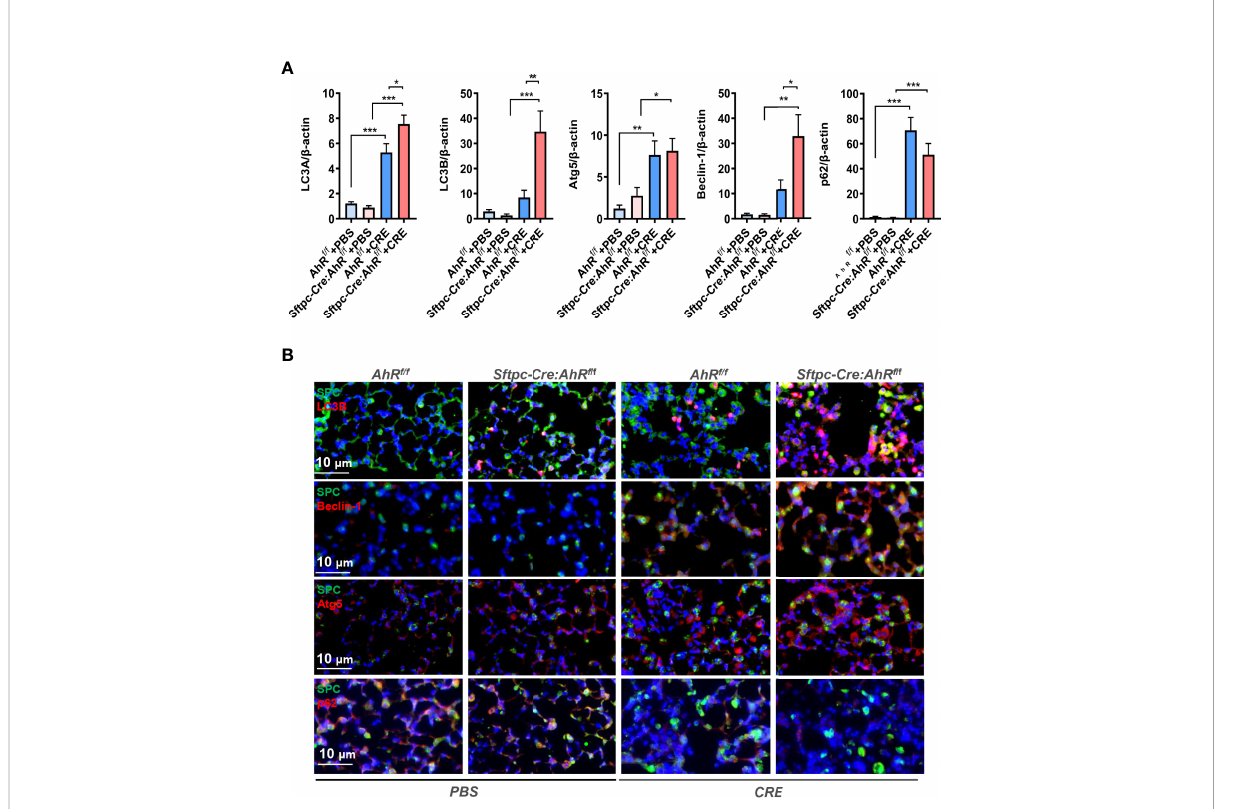
FIGURE 3 Type II alveolar epithelial cell AhR protects against allergen-induced autophagy in a mouse model of asthma. (A) RT-PCR analyses of autophagy-related genes in the lung tissues of asthma mouse model. n = 8 – 12. (B) Representative images of co-immuno fl uorescence staining of autophagy-related genes with AT2 marker SPC. n = 6. Data in (A) represent means ± SEM. * p < 0.05, ** p < 0.01, and *** p <